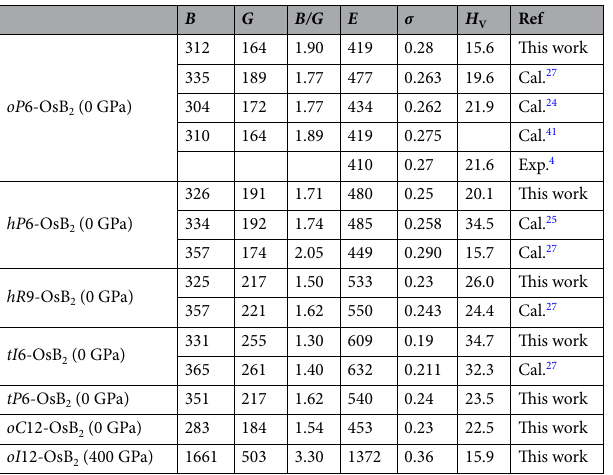
Table 3. Calculated bulk modulus B (in GPa), shear modulus G (in GPa), B / G , Young’s modulus E (in GPa), Poisson’s ratio σ , and hardness H V (in GPa) of different OsB 2 structures, together with available experimental and theoretical results.